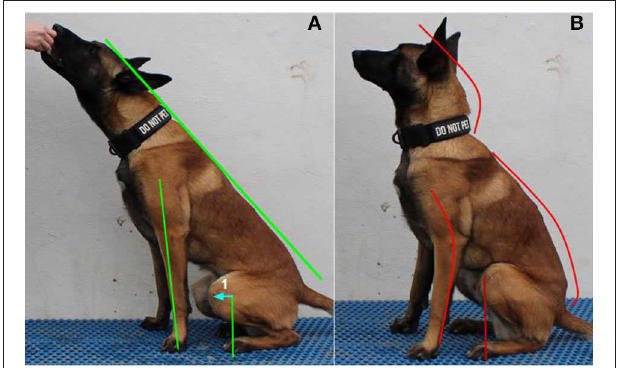
FIGURE 2 | (A) Shows the Posture Sit in the correct position. Note the straight line from the head to the base of the tail. The forelimb is extended in a straight line. The stifle is dorsal to or just cranial to the digits (line 1 shows the range of the stifle over the digits). (B) Shows the Posture Sit in the incorrect position. Note the rounded forelimb and spine (cervical, thoracic, and lumbosacral). The stifle is positioned caudal to the digits.